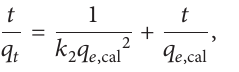
where 𝑘 2 (g bone/mg hour) is the rate constant for pseudo- and 𝑘 2 values second-order adsorption. The constants 𝑞 𝑒, cal were calculated from the slopes and intercepts of 𝑡/𝑞 𝑡 versus 𝑘 𝑡 plots. ℎ 𝑖 value was calculated using 2 rate constant obtained from pseudo-second-order kinetic data and expressed as